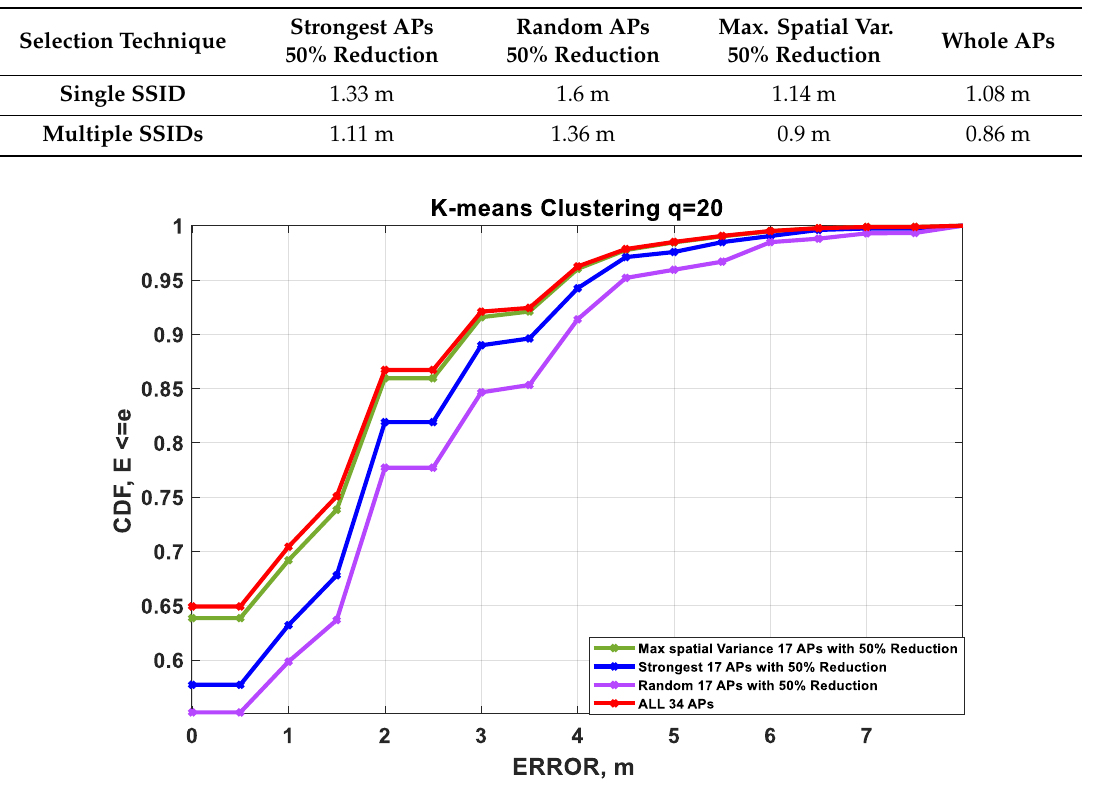
Figure 12. The proposed technique with various kind of AP selection methods.